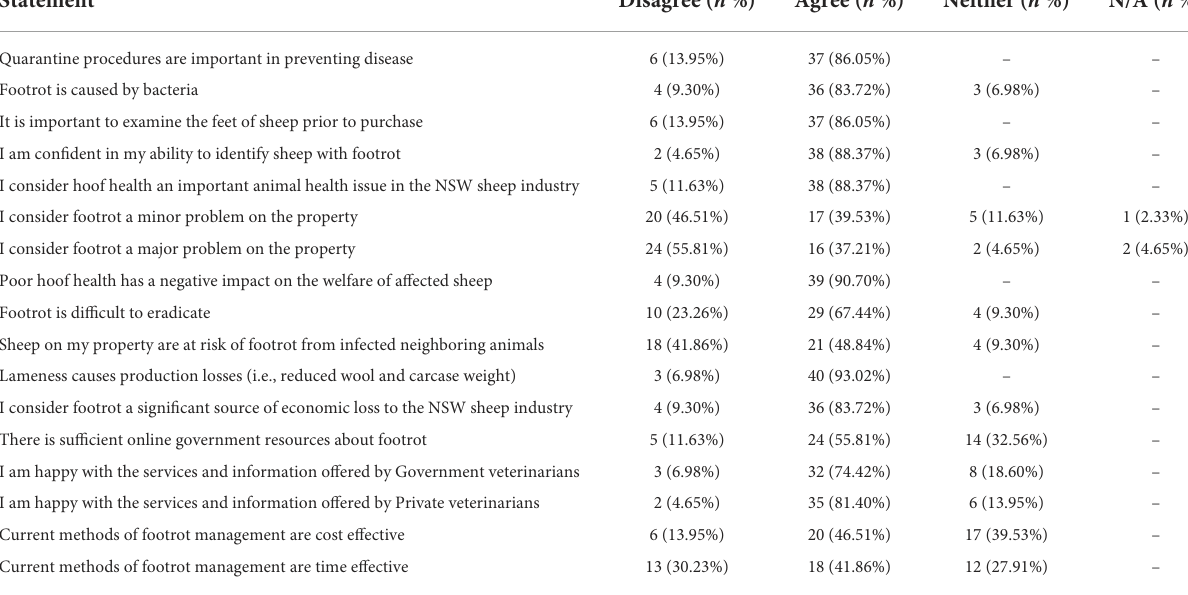
TABLE 3 Summary of participant responses to statements about the less severe forms of footrot including their impact on animal welfare and production and the veterinary resources available to deal with these